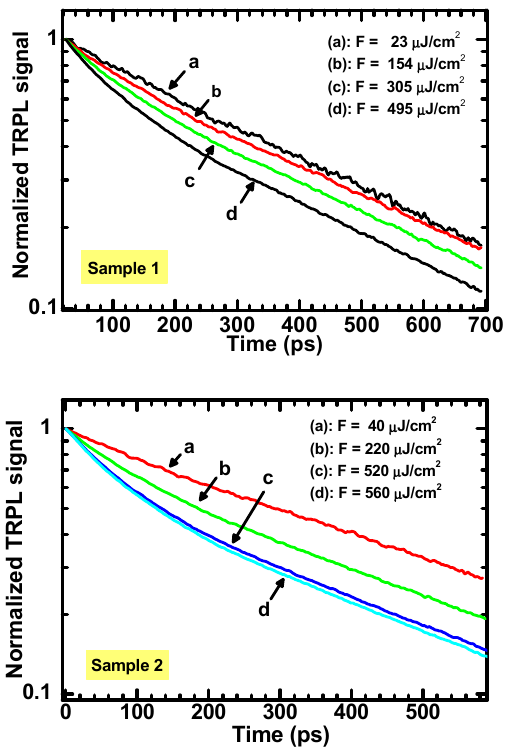
Figure 4. Peak-normalized TRPL curves measured at different values of excitation fluence.